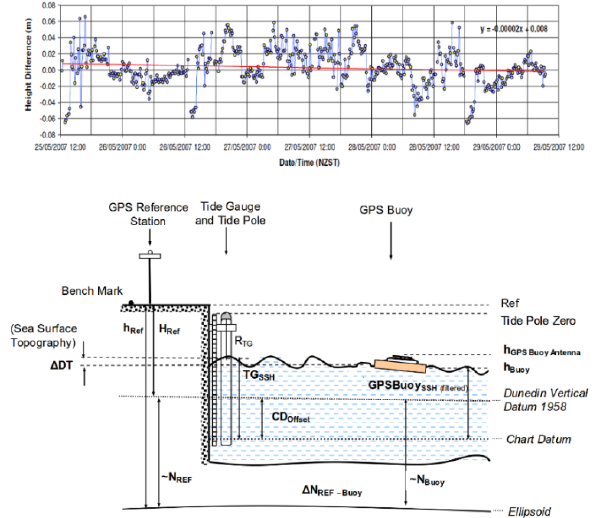
Figure 5. (Top) Difference between the filtered GPS buoys data and the tide gauge (blue) and linear average (red). (Bottom) Datum connections and methodology for verification of the GPS buoy with the tide gauge [5].